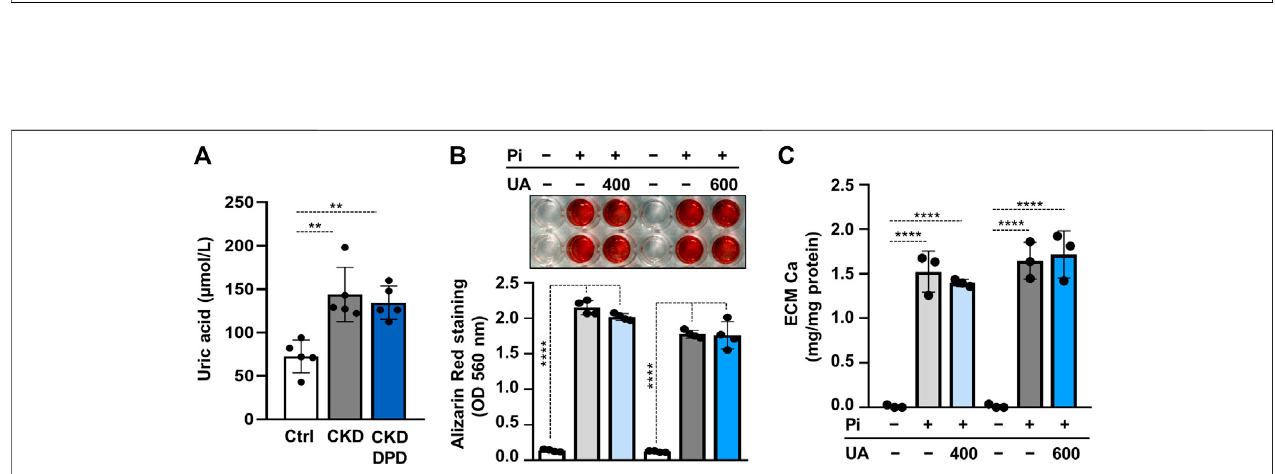
FIGURE7| Uricacidretentionisnotinvolvedinthepro-calci fi cationeffectofDPD. (A) Serumuricacidlevelsincontrol(Ctrl),CKD,andCKD+DPD(15 mg/kg/day) mice ( n = 5). (B,C) VSMCs were exposed to Pi (2 mmol/L) in the presence of uric acid (UA, 400 or 600 μ mol/L) or vehicle. (B) Representative AR staining (day 4) and quanti fi cation ( n = 4). (C) Ca content of HCl-solubilized ECM (day 4, n = 3). Data are expressed as mean ± SD. Ordinary one-way ANOVA followed by Tukey ’ s multiple comparison tests were used to calculate p values. ** p < 0.01, **** p < 0.001.